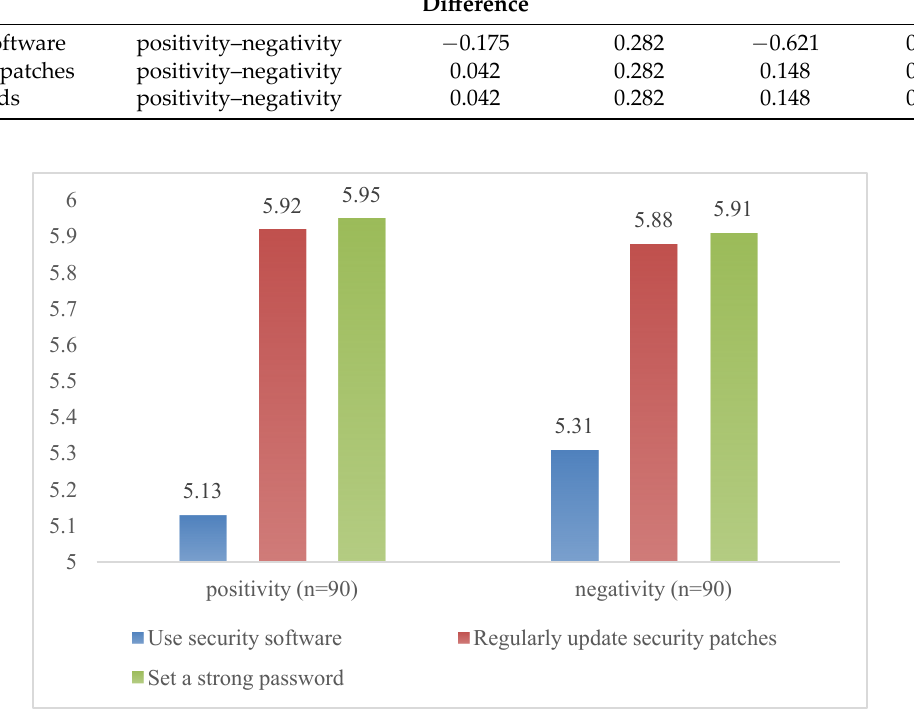
Figure 7. Mean Comparison Plot of Framework Nature and Situation.